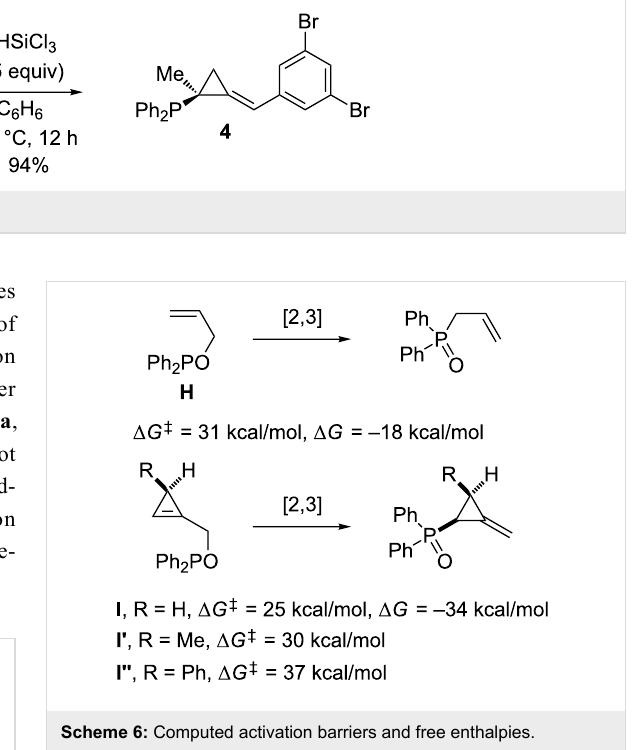
Scheme 6: Computed activation barriers and free